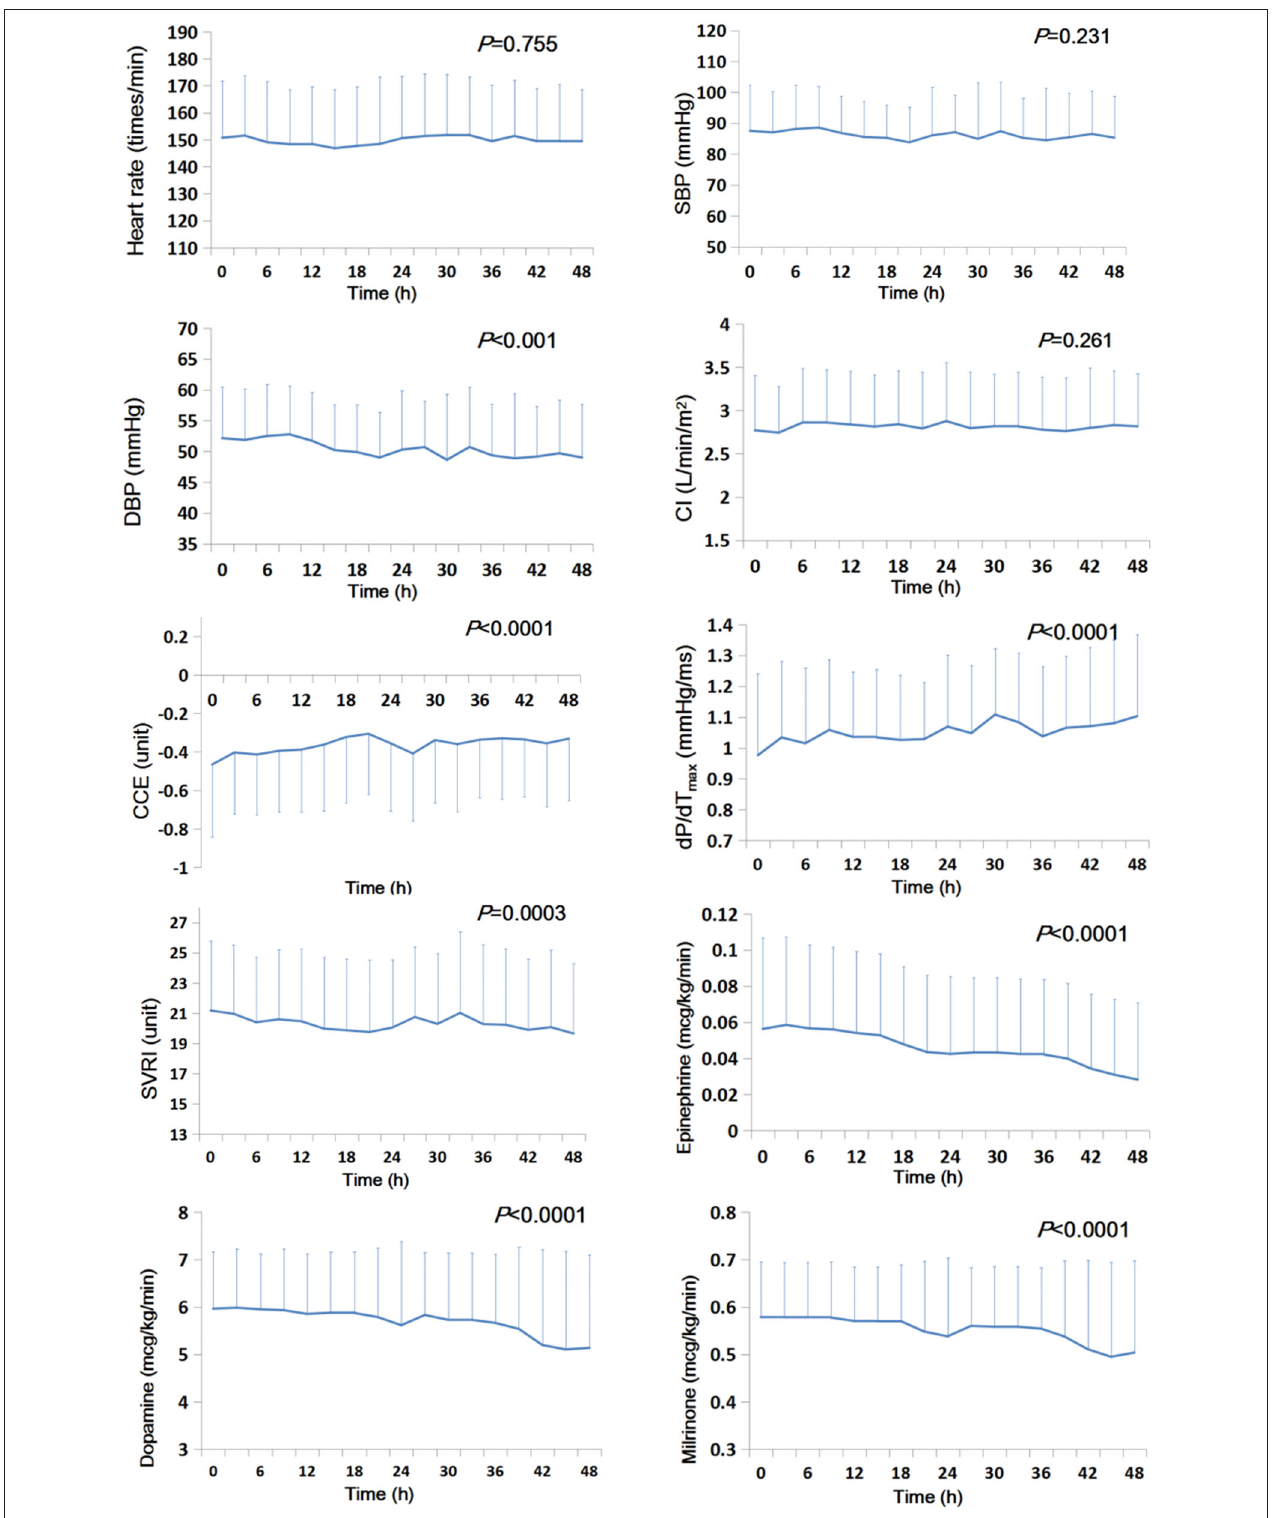
FIGURE 1 | Temporal trends of systemic hemodynamic and myocardial status and doses of inotropic and vasoactive drugs during the first 48h after CPB ( n = 91). The mean value is presented, and the error bar represents the standard deviation. CCE, cardiac cycle efficiency; CI, cardiac index; DBP, diastolic blood pressure; dP/dT max , the maximal slope of systolic upstroke; SBP, systolic blood pressure; SVRI, systematic vascular resistance.